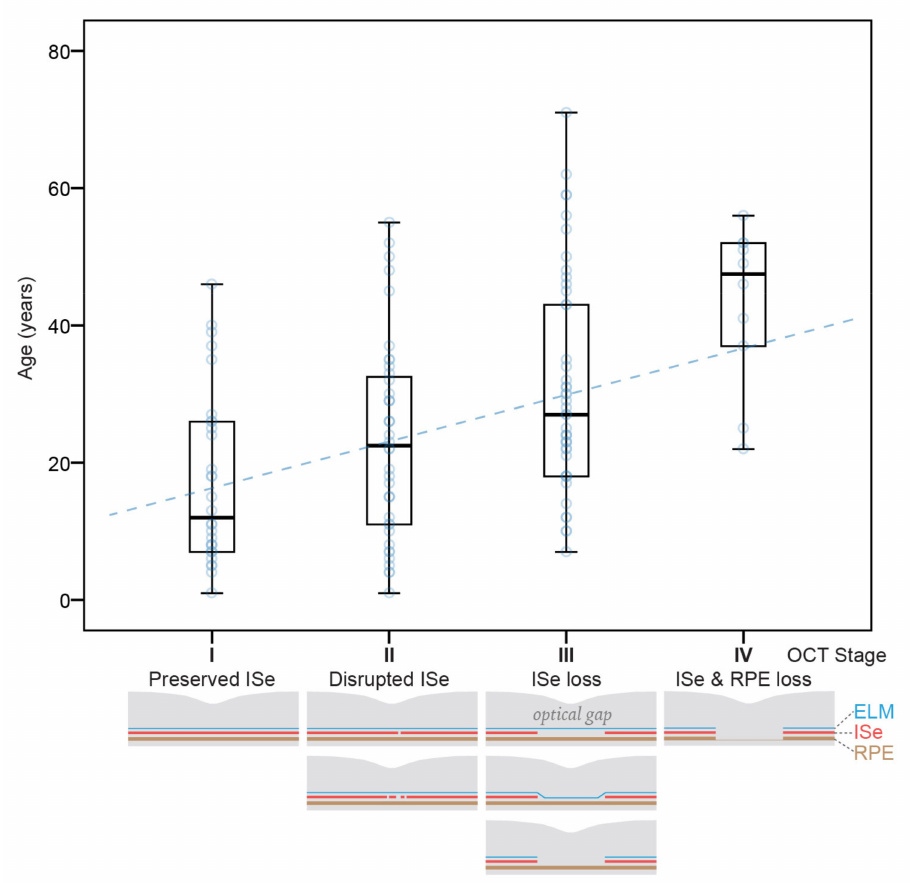
Figure 5. Distribution of patients’ age in different OCT stages. Boxplot chart showing age distribution in groups of patients with OCT stages I-IV. Data from 126 patients were gathered from 7 studies, including ours (Table S1). Possible structural features present in different stages are shown with diagrams at the bottom. Note the increasing age of patients with increasing OCT stage. Horizontal lines represent the median values, boxes represent half of the data for each stage, and whiskers represent the remaining data. Data points for each case are shown with blue circles, and the dashed blue line shows the slope of the regression